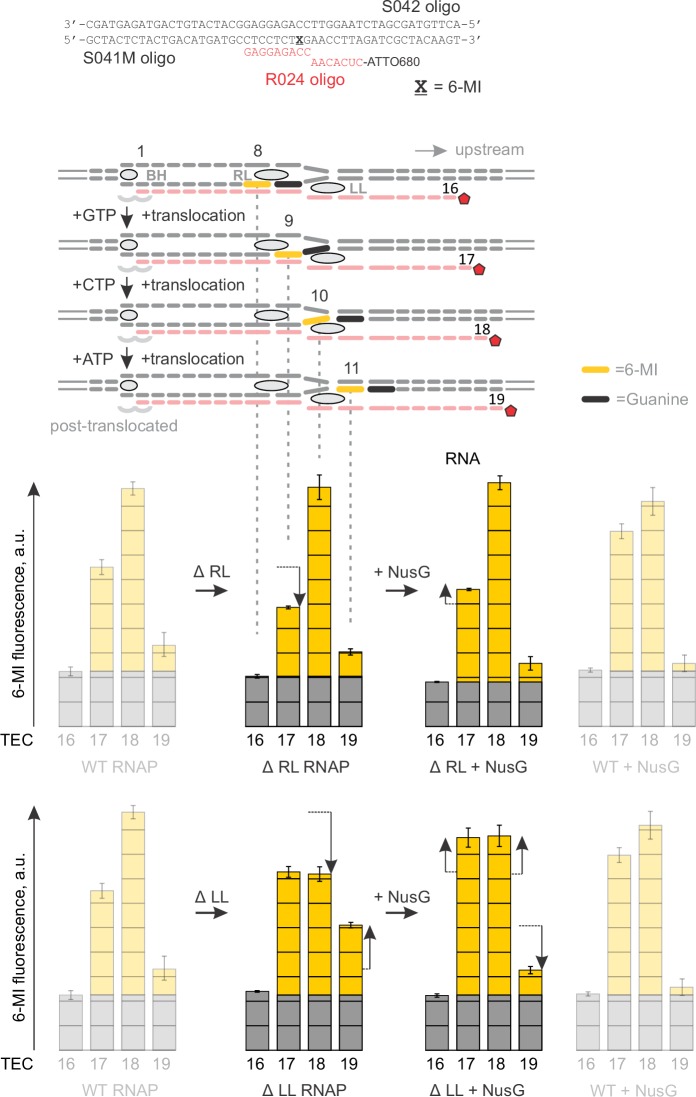
Primary data for Figure 6: the effects of NusG and deletions of the RNAP domains on 6-MI fluorescence.Black vertical arrows depict the changes in fluorescence relative to the neighboring graph on the left. The wild-type TEC data (faded graphs) are presented for comparison. Error bars indicate the range of duplicate measurements or SDs of several measurements (Table 5).